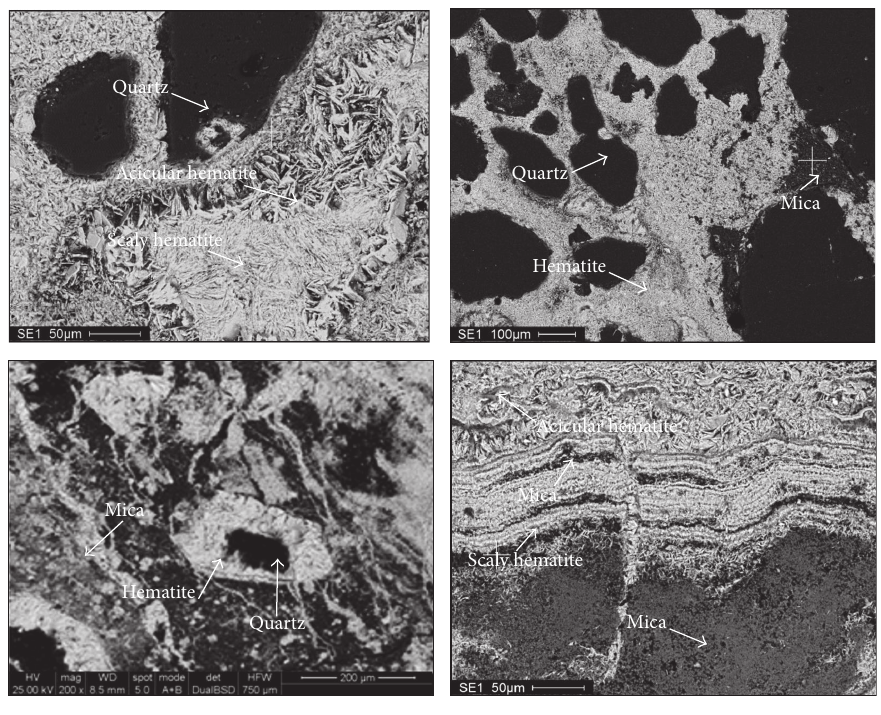
Figure 4: SEM images of the raw hematite ore.